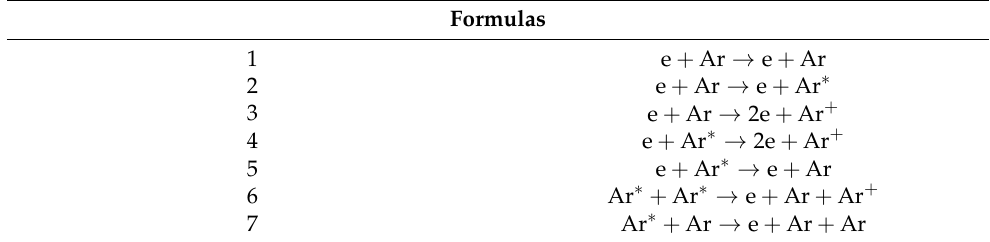
Table 1. Collisions and chemical reactions of argon (Ar) used in the MPJCVD